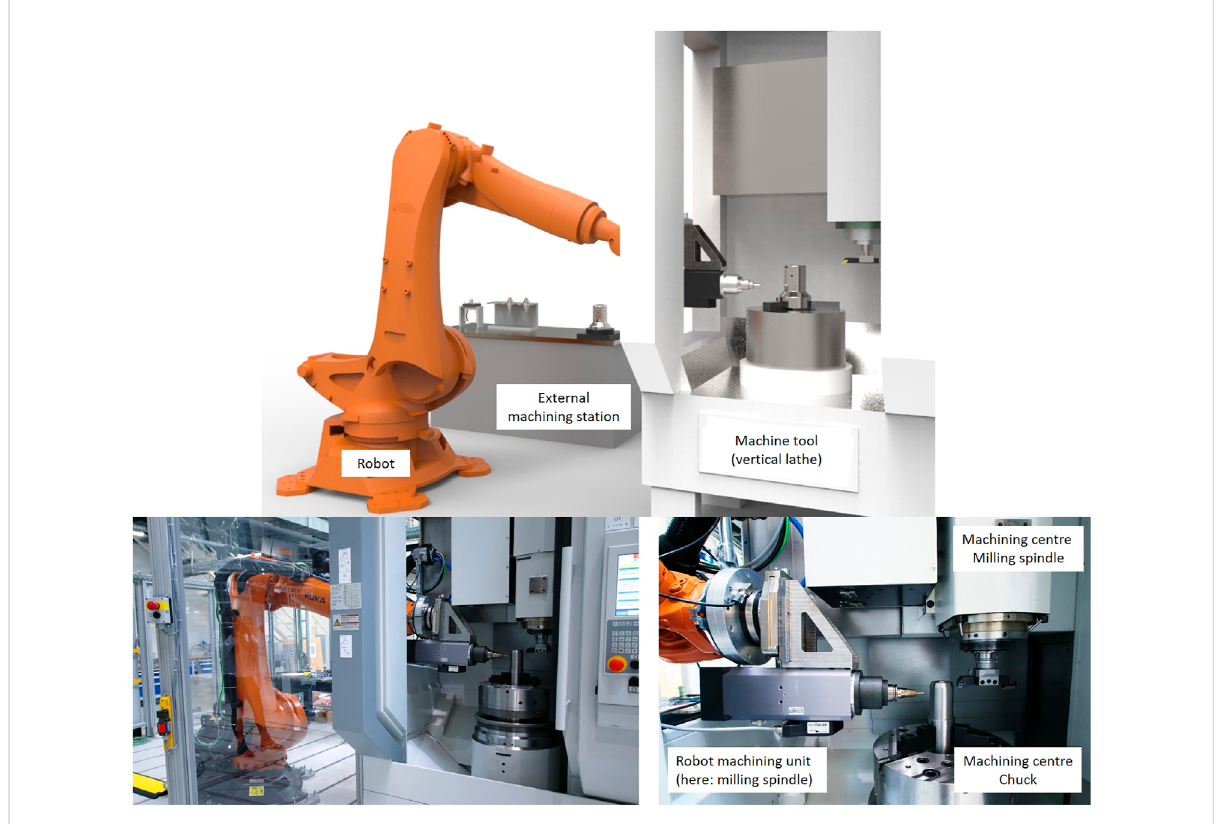
FIGURE 1 Principle of technological robot-machine-collaboration and authors test equipment.